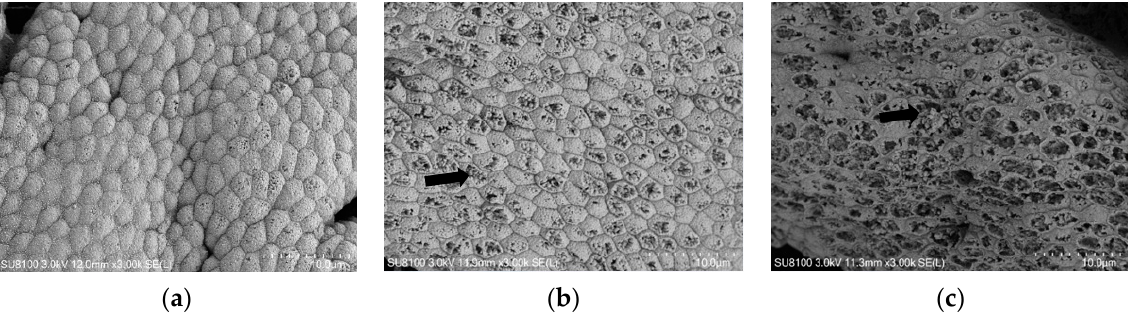
Figure 2. Scanning electron microscopy of gastric mucosa in the hybrid grouper fed with various dietary histamine levels. ( a ) indicates H0 group; ( b ) indicates H24 group; and ( c ) indicates H96 group. Arrows indicate cell damage. The cells of gastric mucosa cells in the H0 group were normal and tightly arranged; some cells in the H24 group were ruptured and the rest were relatively intact; most cells in the H96 group were severely damaged. The magnification was × 3.00 k, and the minimum scale (lower right) was 10.0 μ m.